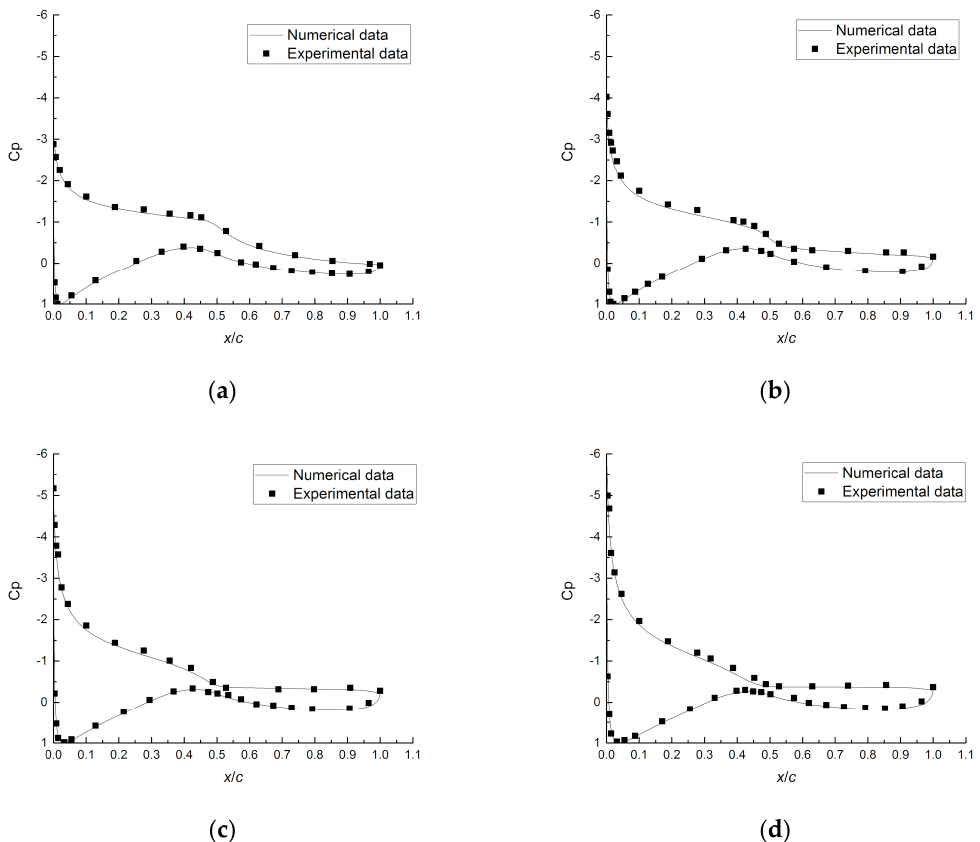
Figure 4. Pressure coefficient distribution comparison for S809 airfoil in one-phase air flow at Re = 1 × 10 6 : ( a ) α = 8.2°; ( b ) α = 10.1°; ( c ) α = 12.2°; ( d ) α = 14.2°.